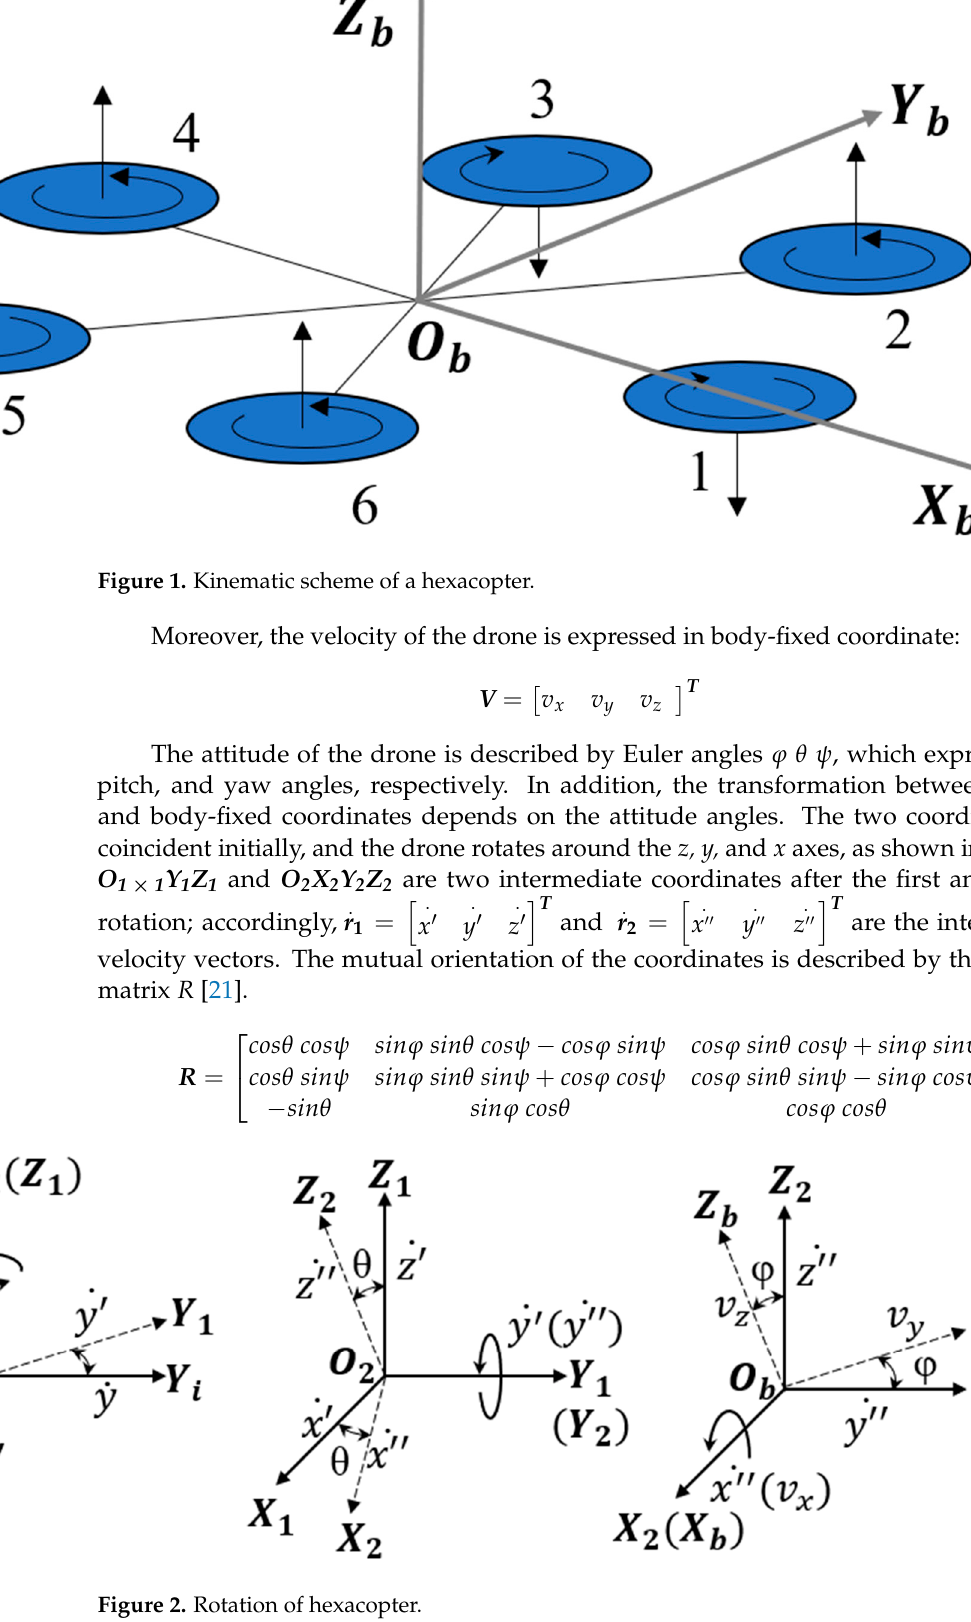
Figure 2. Rotation of hexacopter.